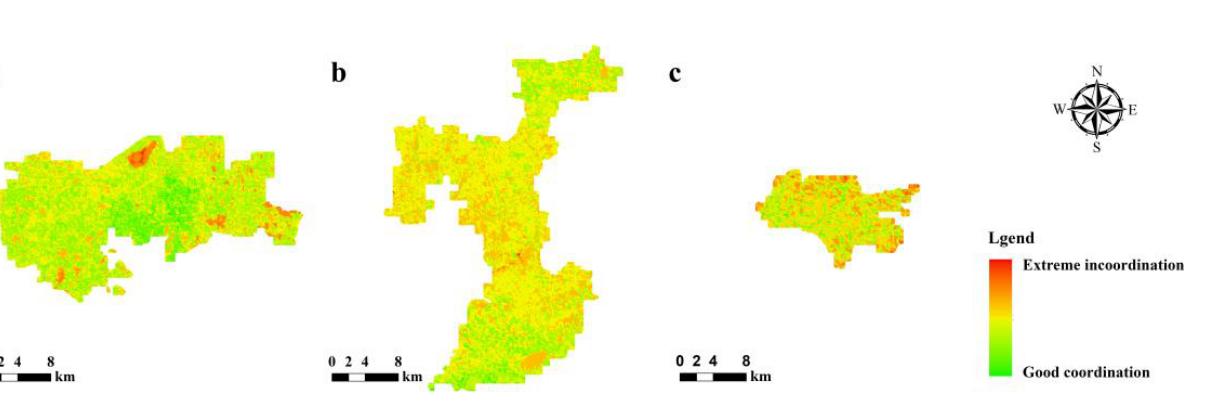
Figure 8. Distribution of the CCD between CIS and CID ( a ) Jinan ( b ) Qingdao ( c ) Heze.